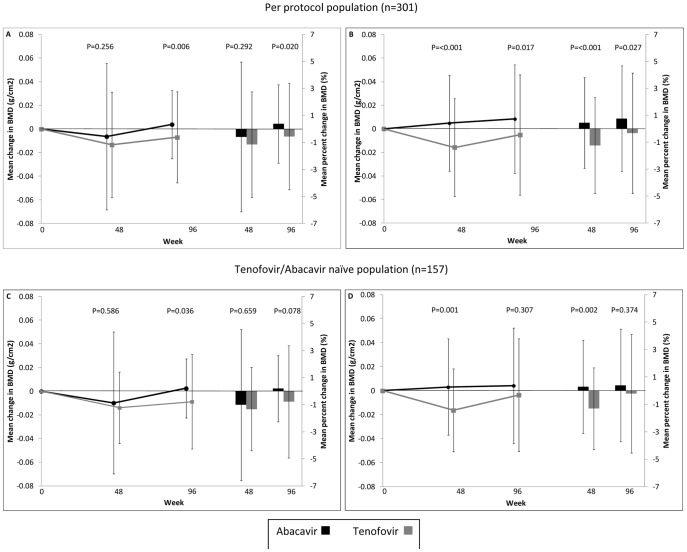
Mean change from baseline to week 96 in right hip (A,B) and lumbar spine bone mineral density (C,D) by study population and randomised arm (abacavir-lamivudine vs. tenofovir-emtricitabine).The right hand side of each graph shows the mean percent change in BMD at weeks 48 and 96. Note. p values from t-test comparing mean change from baseline to study week of interest in randomized arms. Error bars represent 1 standard deviation from the mean.Abbreviations: ABC/3TC, abacavir/lamivudine; TDF/FTC, tenofovir/emtricitabine.